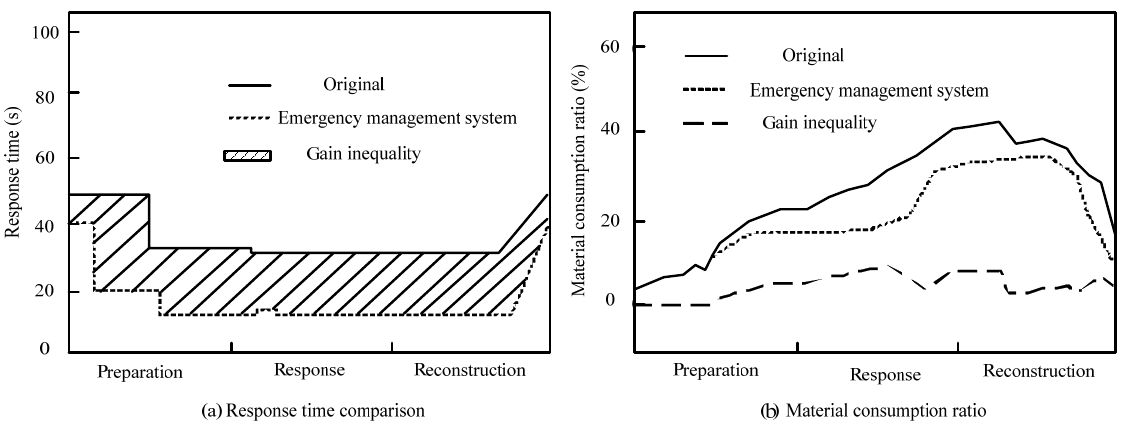
Figure 10. Practical application analysis of emergency management system. As shown in Figure 10a, in the preparation stage, the reaction time in the original means starts from 50s, and with the arrival of the warning, the reaction time begins to drop to 32s. At the same time, the corresponding management team begins to formulate measures. With the advent of geological disasters, the response time is further reduced, but only by 1s. With the development of disaster relief and reconstruction work, the response time returns to normal. Under the emergency management system, the initial preparation time is set to 40s, and in the early warning, the response time is reduced to 13s, which is 59.4% higher, compared to the original means. However, in disaster relief, the response time is increased by 1s. The reason is that the population data change affects the information of the big data platform, resulting in short-term changes, and finally, the change trend in the reconstruction is consistent with that of the original means. Figure 10b shows the material consumption change process. With the support of the original means, the highest material consumption reaches 42.1% during the reconstruction process. With the support of the emergency management system, the maximum material consumption reduces to 35.7%. In the entire consumption process, the emergency management system displays